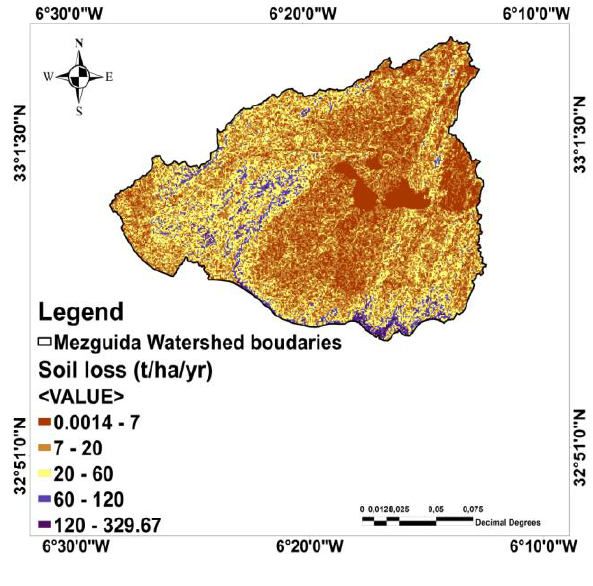
Figure 9. Soil loss